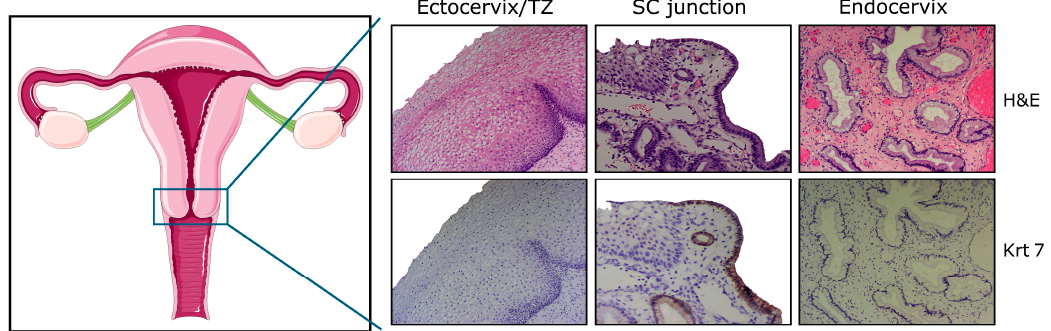
Figure 1. Schematic representation of the female genital tract and histology of the adult cervix with ectocervical (squamous), junctional (cuboidal), and endocervical (columnar) cells. Note the uniform keratin 7 (Krt7) immunoreactivity displayed by cuboidal cells observed within, or in close proximity to, the squamo-columnar (SC) junction. H&E: hematoxylin and eosin; TZ: transformation zone.